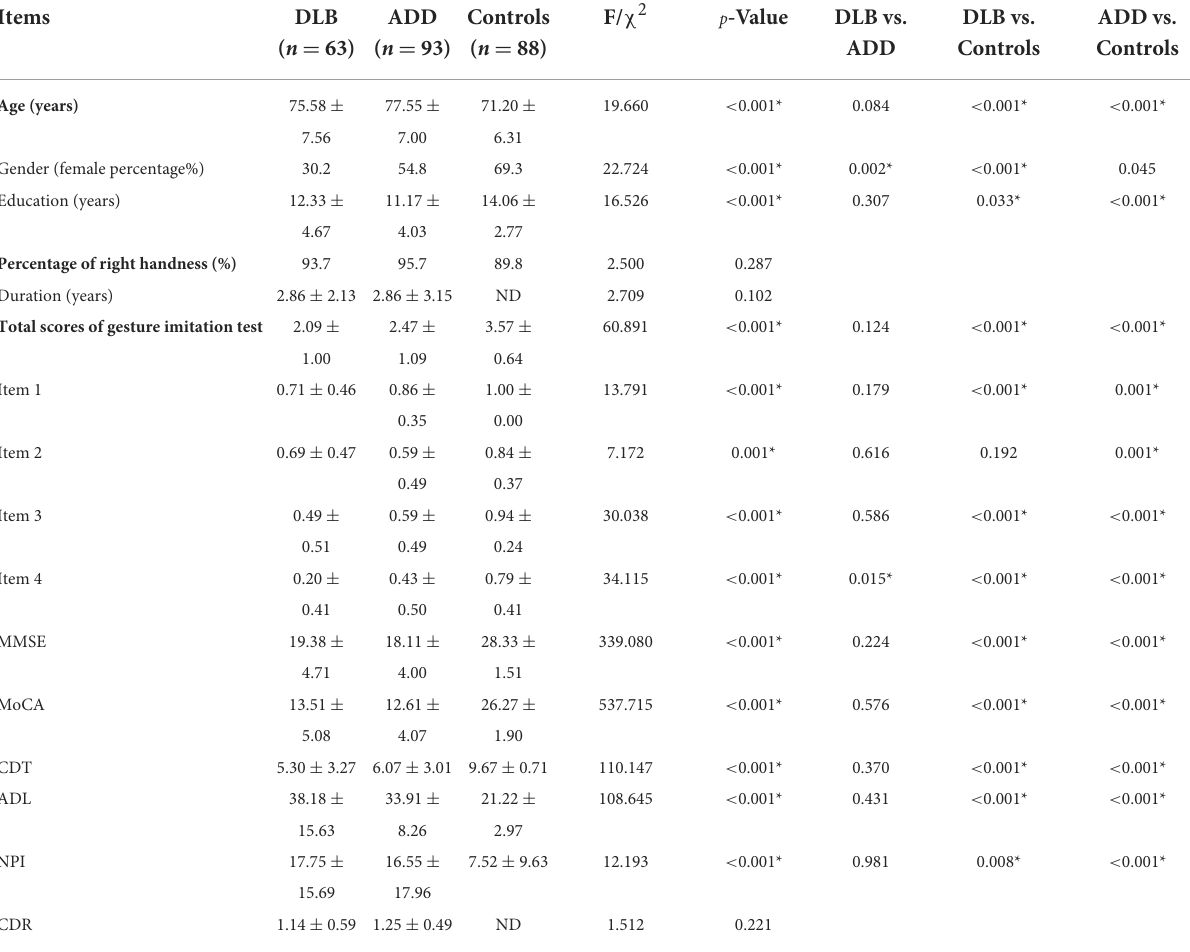
TABLE 1 The demographic, neuropsychological data and gesture imitation test of the patients with DLB and ADD and the healthy controls. Items DLB